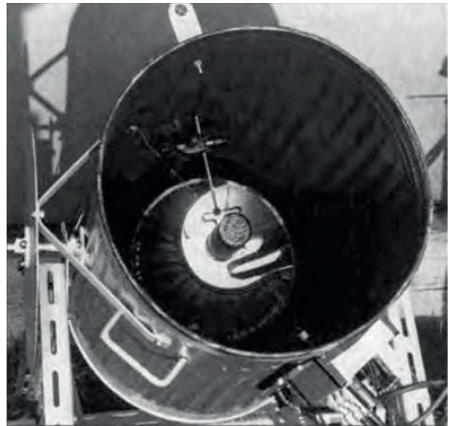
Figure 4. The detector used by Galbraith and Jelley for the first observations of atmospheric-Cherenkov radiation: a dustbin with a small parabolic mirror and phototube